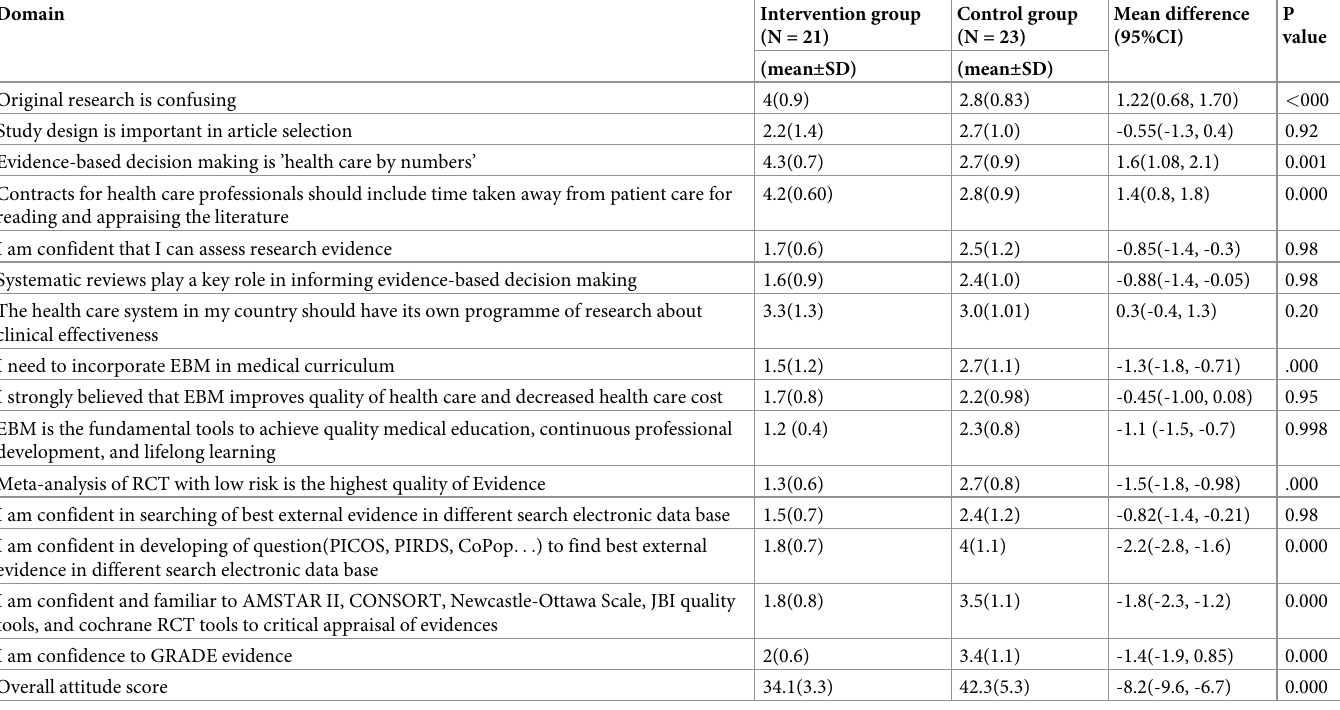
Table 3. Change of attitude after training among postgraduate specialty students in Ethiopia, 2022.